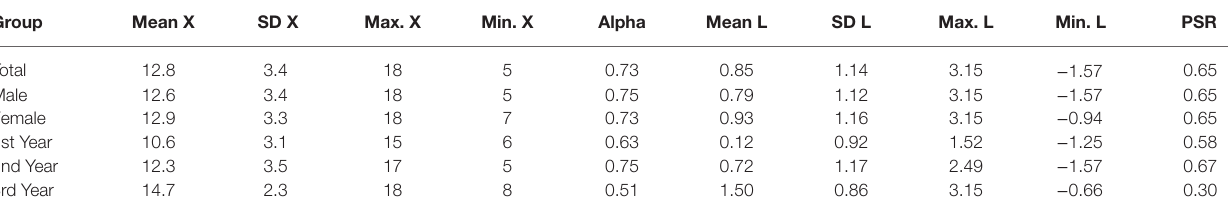
TABLE 7 | Social thinking. Descriptive statistics of the participants’